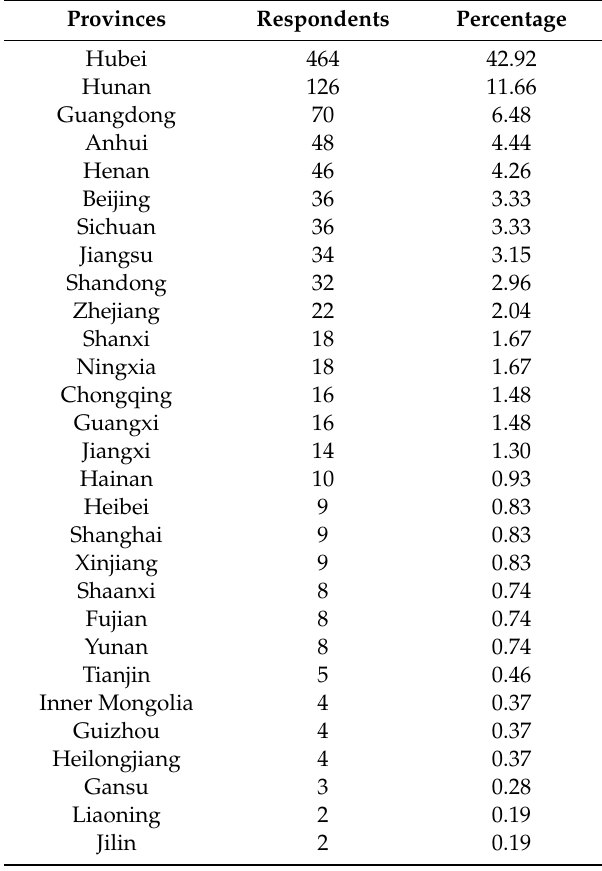
Table 1. Distribution of the